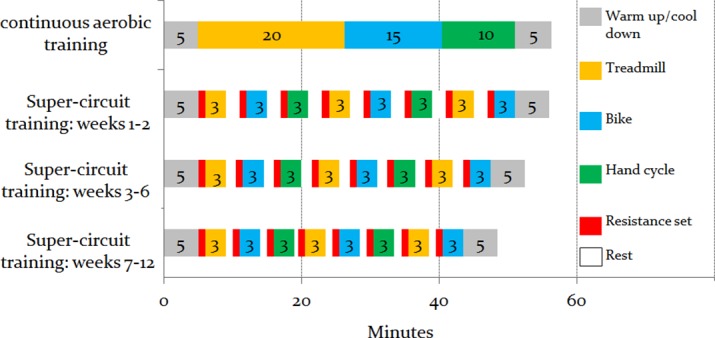
Continuous aerobic group and super-circuit group–training protocols.Notes: The figure illustrates the training modalities (i.e., treadmill, bike, hand cycle and resistance training) used in each training group. Each training modality is denoted in a different color. The numbers that appear inside the boxes denote the number of minutes engaged in the designated training modality; in the super-circuit group, in weeks 1–2, 3–6 and 7–12, the rest interval was of two minutes, one and a half minute and one minute, respectively.